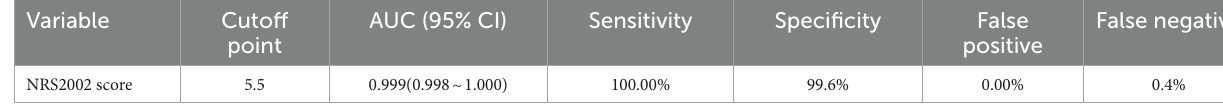
TABLE 7 The performance of various methods for distinguishing between cured and death ( n =